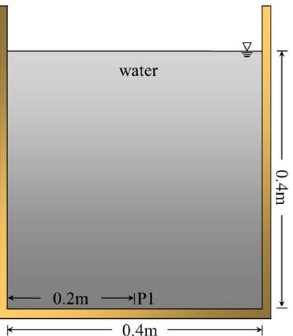
Figure 3. Set-up for a hydraulic pressure test simulation.